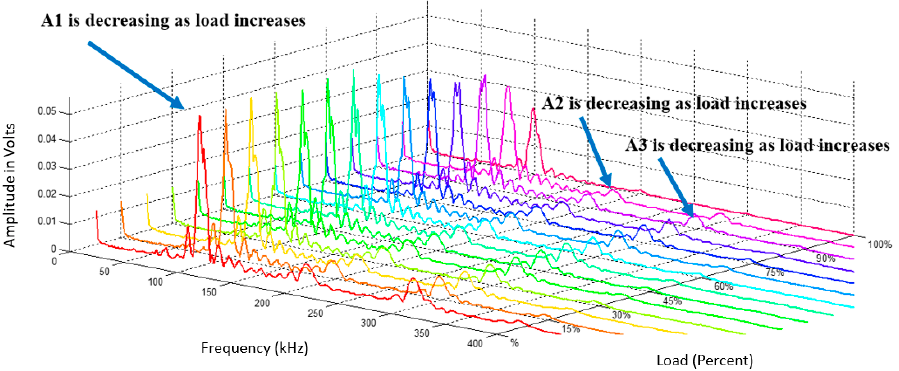
Figure 2. Nonlinear ultrasonic test using higher harmonic generations A1, A2, and A3 in frequency-domain recorded from the receiver (Ongpeng et al., 2016 [20]).